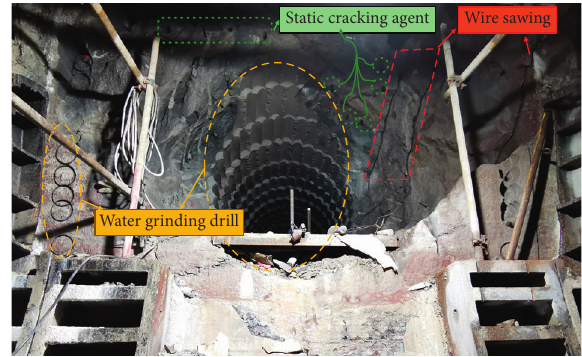
Figure 5: Rock fracturing effect of different excavation